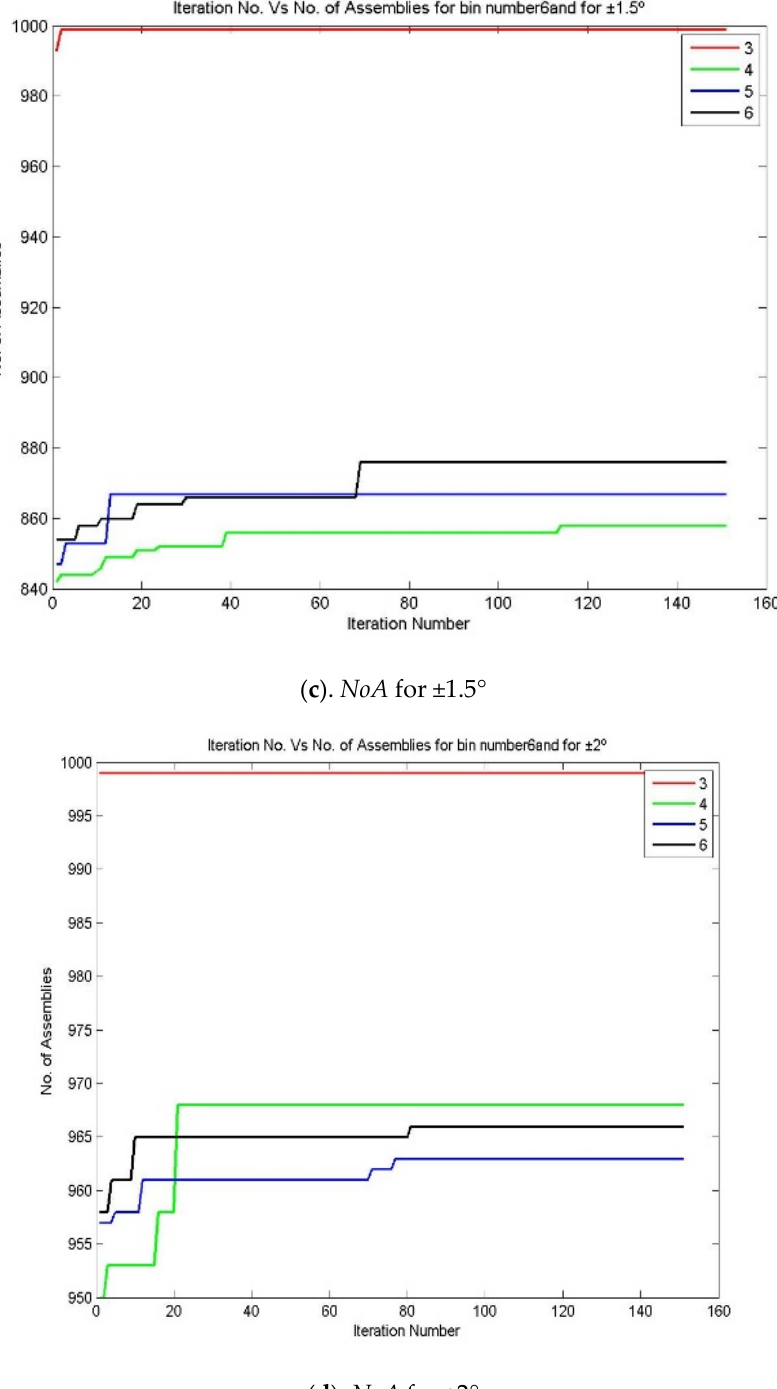
Figure 4. Iteration number vs. NoA for various bin numbers—the 3213 process combination (a) NoA for ± 0.5°, (b) NoA for ± 1°, (c). NoA for ± 1.5° and (d) NoA for ± 2°